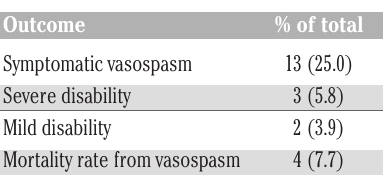
Table 3. Results obtained from the proto- col for cerebral vasospasm used to manage 52 patients suffering from aneurysmal subarachnoid